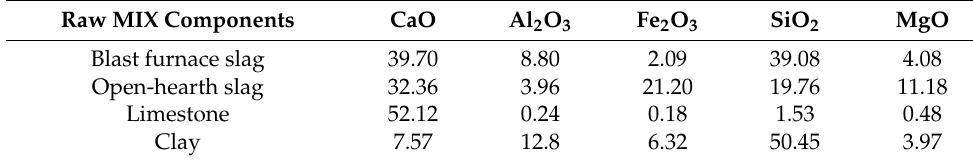
Table 1. Chemical composition of slag [%]